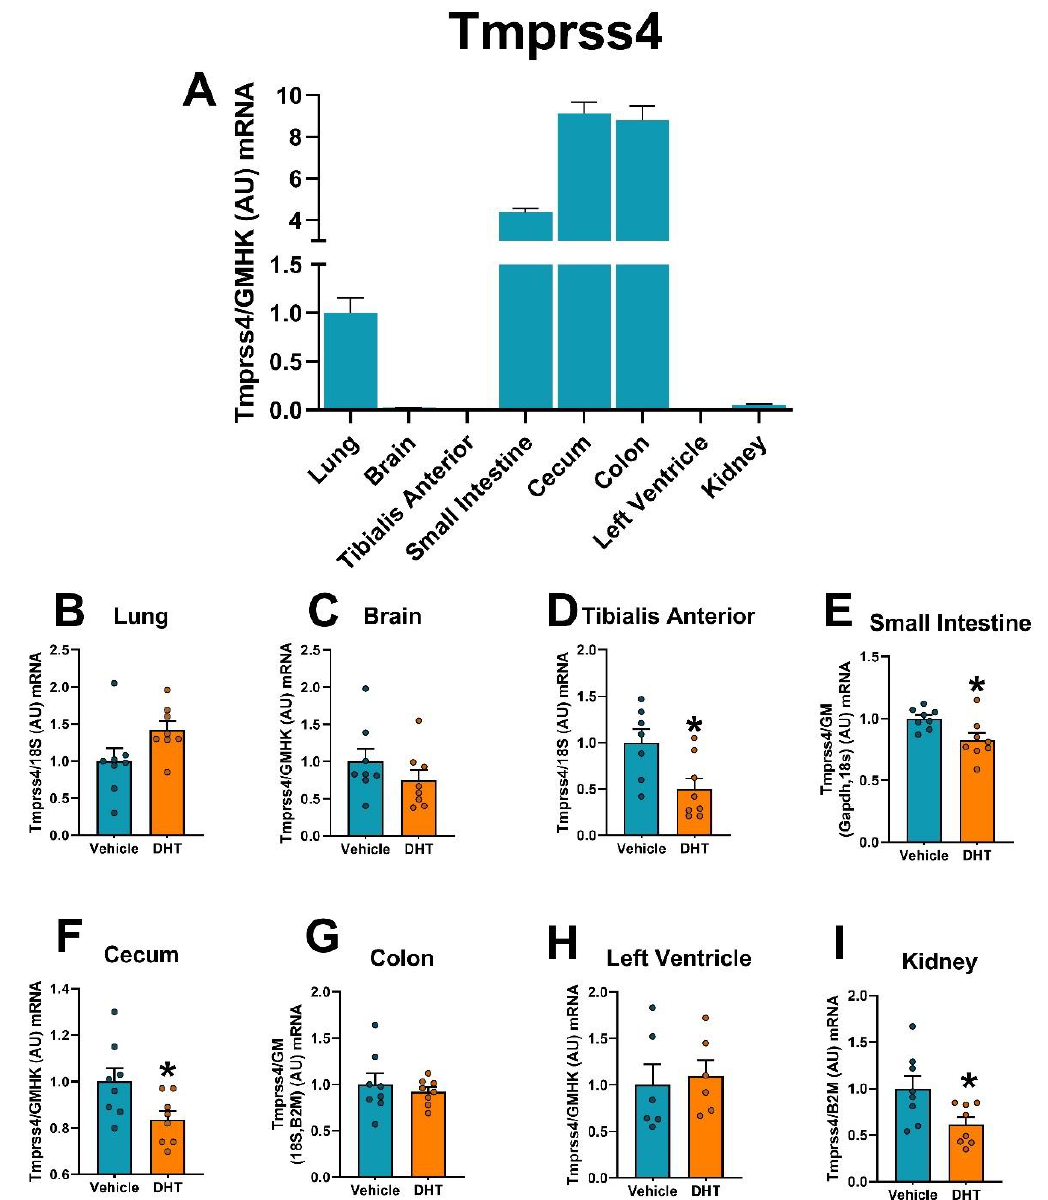
Figure 10. Tmprss4 mRNA expression regulation by DHT in different tissues. Tmprss4 mRNA expression was quantified by RT-qPCR. ( A ) Tmprss4 mRNA expression in control mice normalized to the geometric mean of all reference genes and expressed relative to lung tissue. ( B – I ) Tmprss4 mRNA expression in the lung ( B ), brain ( C ), tibialis anterior ( D ), small intestine ( E ), cecum ( F ), colon ( G ), left ventricle ( H ), and kidney ( I ) of control and DHT-treated mice normalized to the least variable reference gene or set of them and expressed relative to control mice. Data analyzed by t -test. n = 7–8/group. *: p < 0.05.